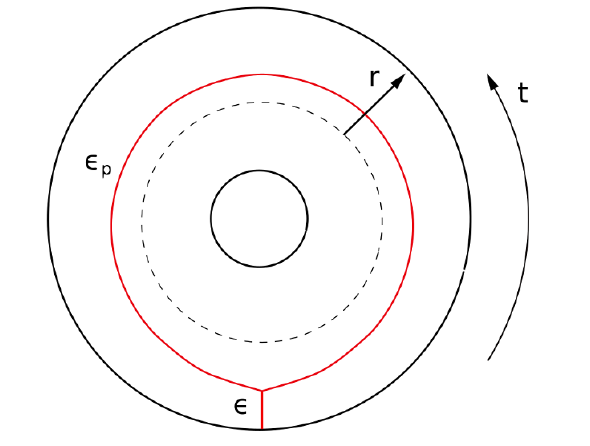
Figure 2 . The con(cid:12)guration of geodesics in thermal AdS 3 , which is holographically dual to the linearized semiclassical 1-point conformal block on the torus. The intersection of the solid torus with the plane, in which the circle r = 0 (represented by a dotted line) lies, is